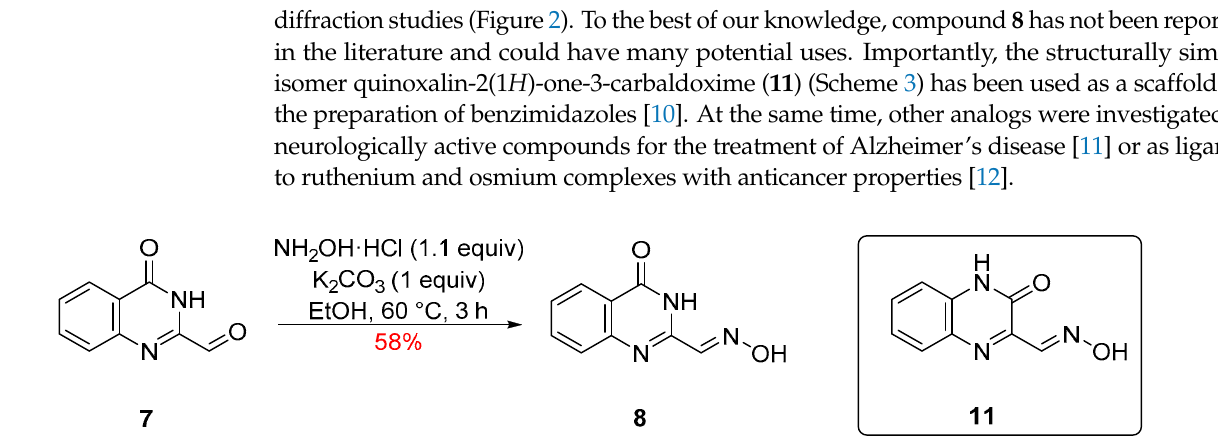
Figure 2. Geometry of ( E )-4-oxo-3,4-dihydroquinazoline-2-carbaldehyde oxime ( 8 ) in the crystal; crystallographic atom numbering. Thermal ellipsoids at 50% probability.